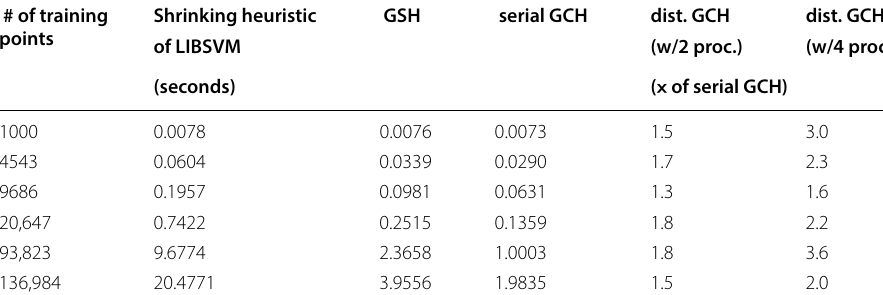
Table 14 Scaling improvements of the heuristic approaches # of training points